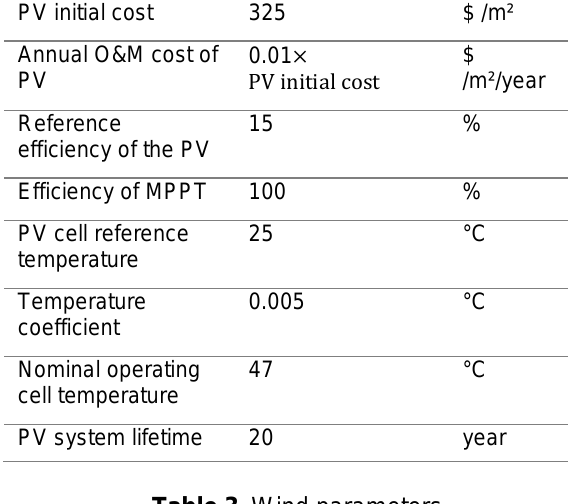
Table 2 . PV parameters